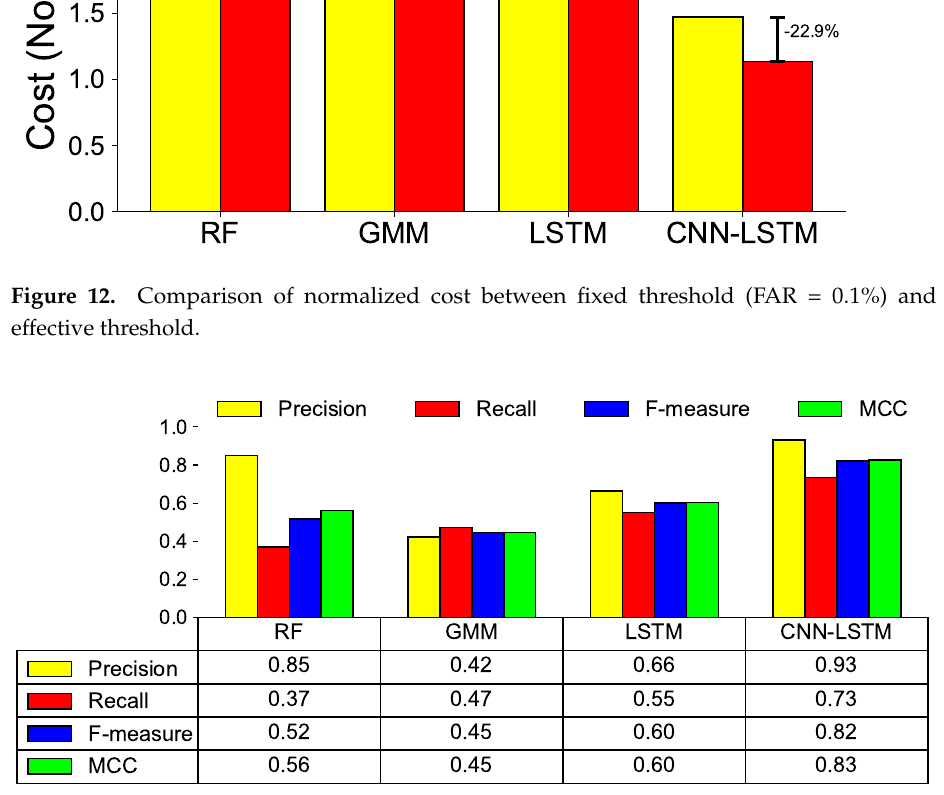
Figure 13. Model prediction results using various performance metrics with the minimum